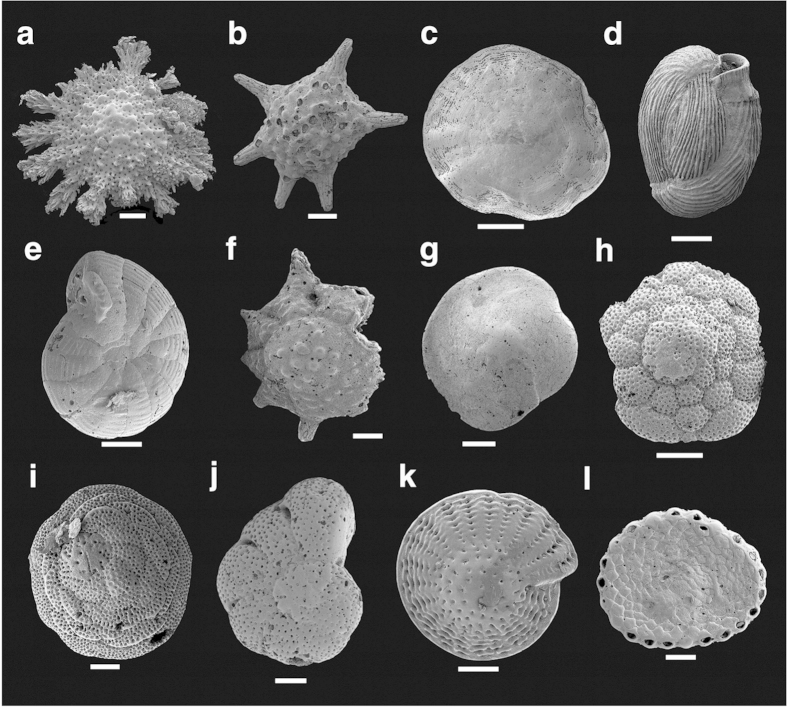
Dominant foraminifera taxa from Heron Reef flat across the four sampling intervals.Plate shows 12 most abundant species in rank abundance order. All illustrated specimens from 2008 interval. Full species name, specimen number, specimen view and length of scale bar provided for each specimen. (a) Calcarina hispida Brady, MU 63014, aboral view, scale bar = 200 μm. (b) Baculogypsina sphaerulata (Parker and Jones), MU 63009, lateral view, scale bar = 200 μm. (c) Marginopora vertebralis Quoy and Gaimard, MU 62931, lateral view, scale bar = 2 mm. (d) Quinqueloculina neostriatula Thalmann, MU 62867, lateral view, scale bar = 200 μm. (e) Peneroplis pertusus (Forskål), MU 62920, lateral view, scale bar = 100 μm. (f) Neorotalia calcar (d’Orbigny), MU 63007, aboral view, scale bar = 100 μm. (g) Amphistegina lobifera Larsen, MU 63003, aboral view, scale bar = 200 μm. (h) Cymbaloporetta bradyi (Cushman), MU 62982, aboral view, scale bar = 100 μm. (i) Millettiana milletti (Heron-Allen and Earland), MU 62985, aboral view, scale bar = 100 μm. (j) Epistomaroides punctatus (Said), MU 62995, lateral view, scale bar = 100 μm. (k) Elphidium craticulatum (Fichtel and Moll), MU 63018, lateral view, scale bar = 200 μm. (l) Sorites orbiculus Forskål, 1775, MU 62934, lateral view, scale bar = 100 μm. All SEM images taken by the authors.